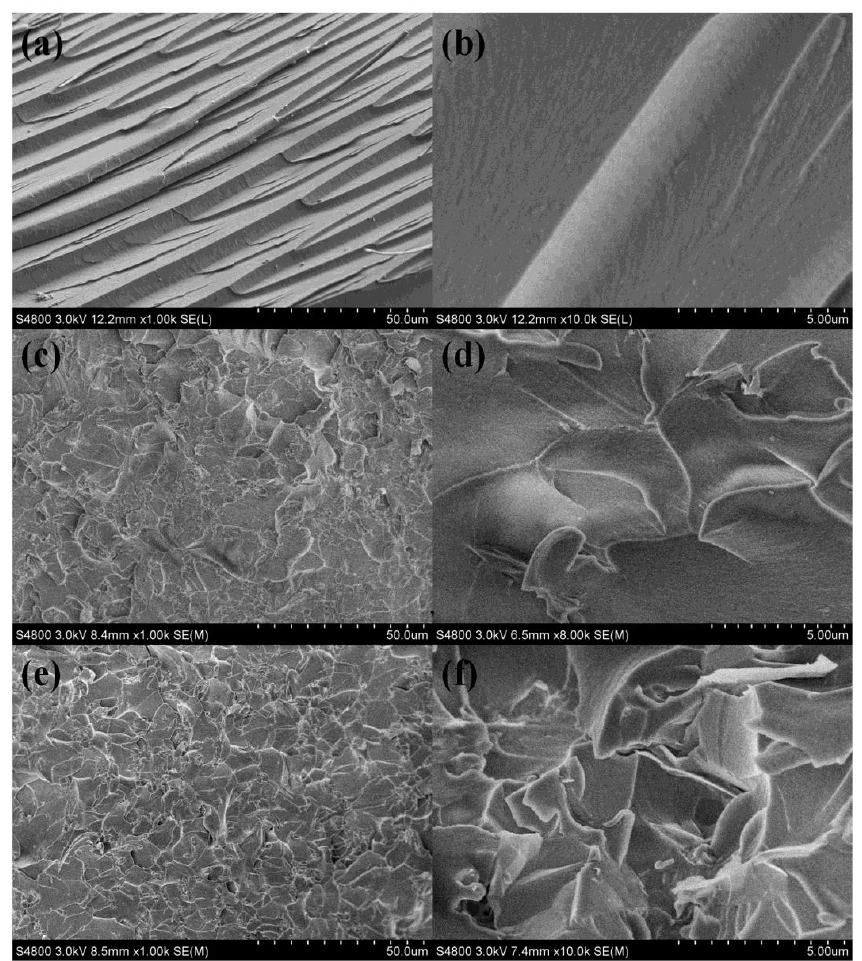
Figure 9. SEM images of fractured surface of composites with different enlargement fractions: ( a , b ) neat epoxy, ( c , d ) 0.49 wt % GNs, ( e , f ) 1.96 wt % GNs.